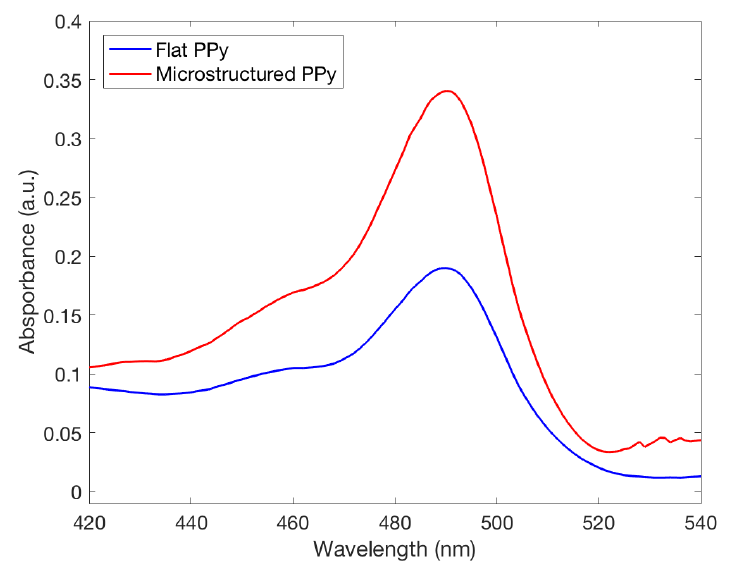
Figure 8. Fluorescence spectra of fluorescein released from both flat and microstructured polypyrrole films in a solution with a pH of 8.0, commonly seen in chronic wounds. The microstructured film can be seen having an increased doping capacity at this